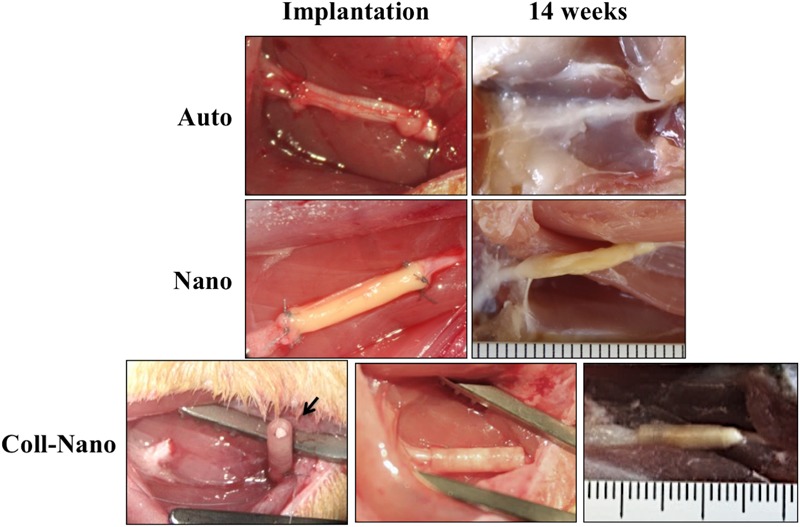
Implantation and postoperative aspect of repaired sciatic nerves. These images show the macroscopic aspect of repaired nerves and the postoperative results for autografts (Auto), NFABNS (Nano) and collagen conduits filled with one NFABNS (Coll-Nano). In all cases the nerve gap was successfully bridged after 14 weeks. In Coll-Nano group, the collagen conduits were first sutured in one of the nerve stump, filled with one 1-mm diameter NFABNS (arrow) and then the opposite nerve stump was inserted and sutured into the conduits. Please note that all images at 14 weeks were taken after perfusion.